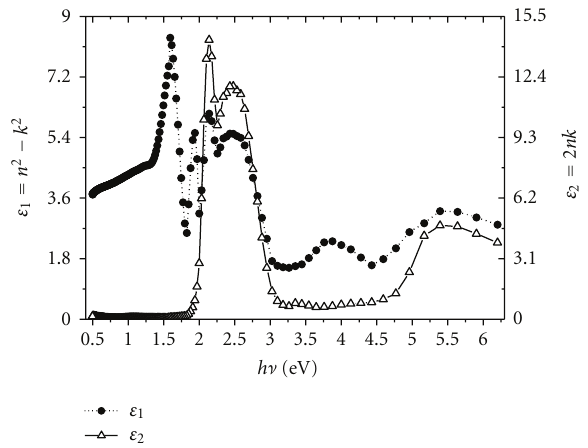
Figure 9: The plot of ( αh ν ) 1 / 2 versus the incident photoenergy ( h ν ) for PTCDI films.